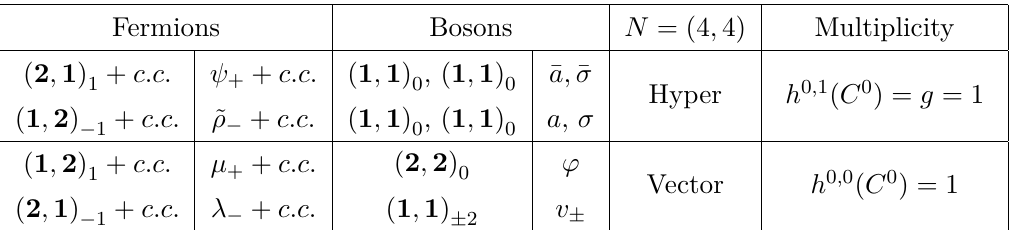
Table 1 . Spectrum of massless 2d N = (4 , 4) multiplets on the worldsheet of a string obtained by wrapping a D3-brane on the genus-one curve C 0 ⊂ K 3 with C 0 · C 0 = 0 . The first column indicates the representations with respect to SU(2) 2d left/right-moving